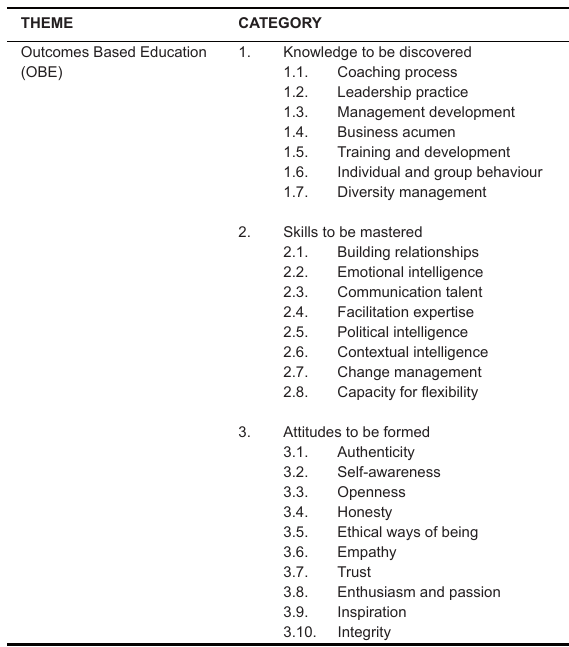
TABLE 1 Overview of the themes, categories and sub-categories of the participants’